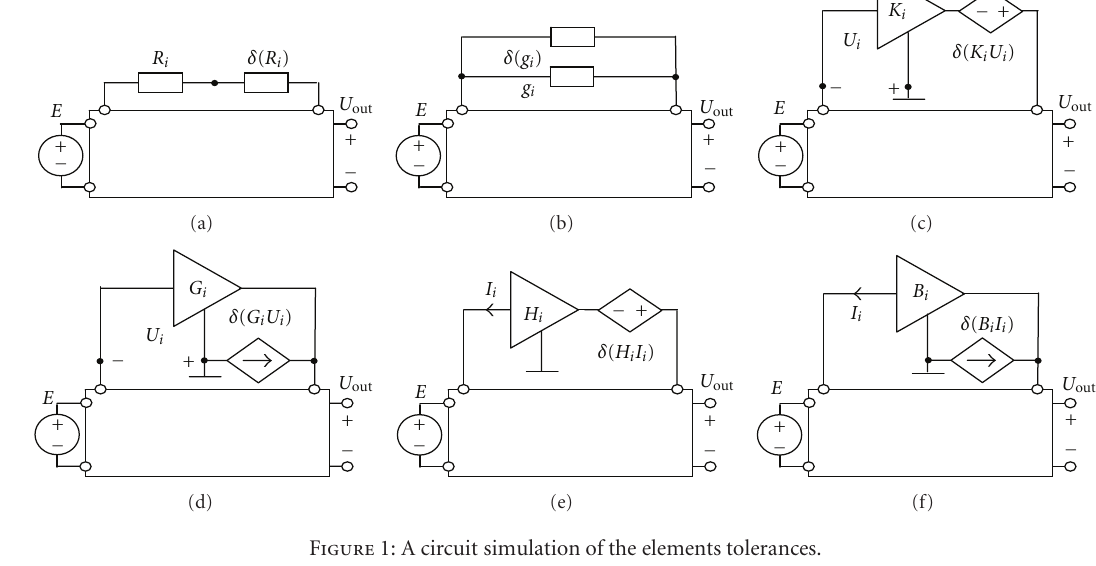
Figure 1: A circuit simulation of the elements